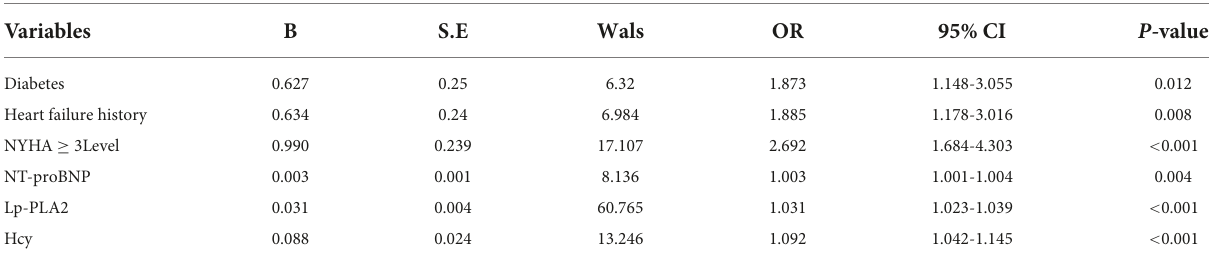
TABLE 3 Multivariate analysis of independent risk factors associated with